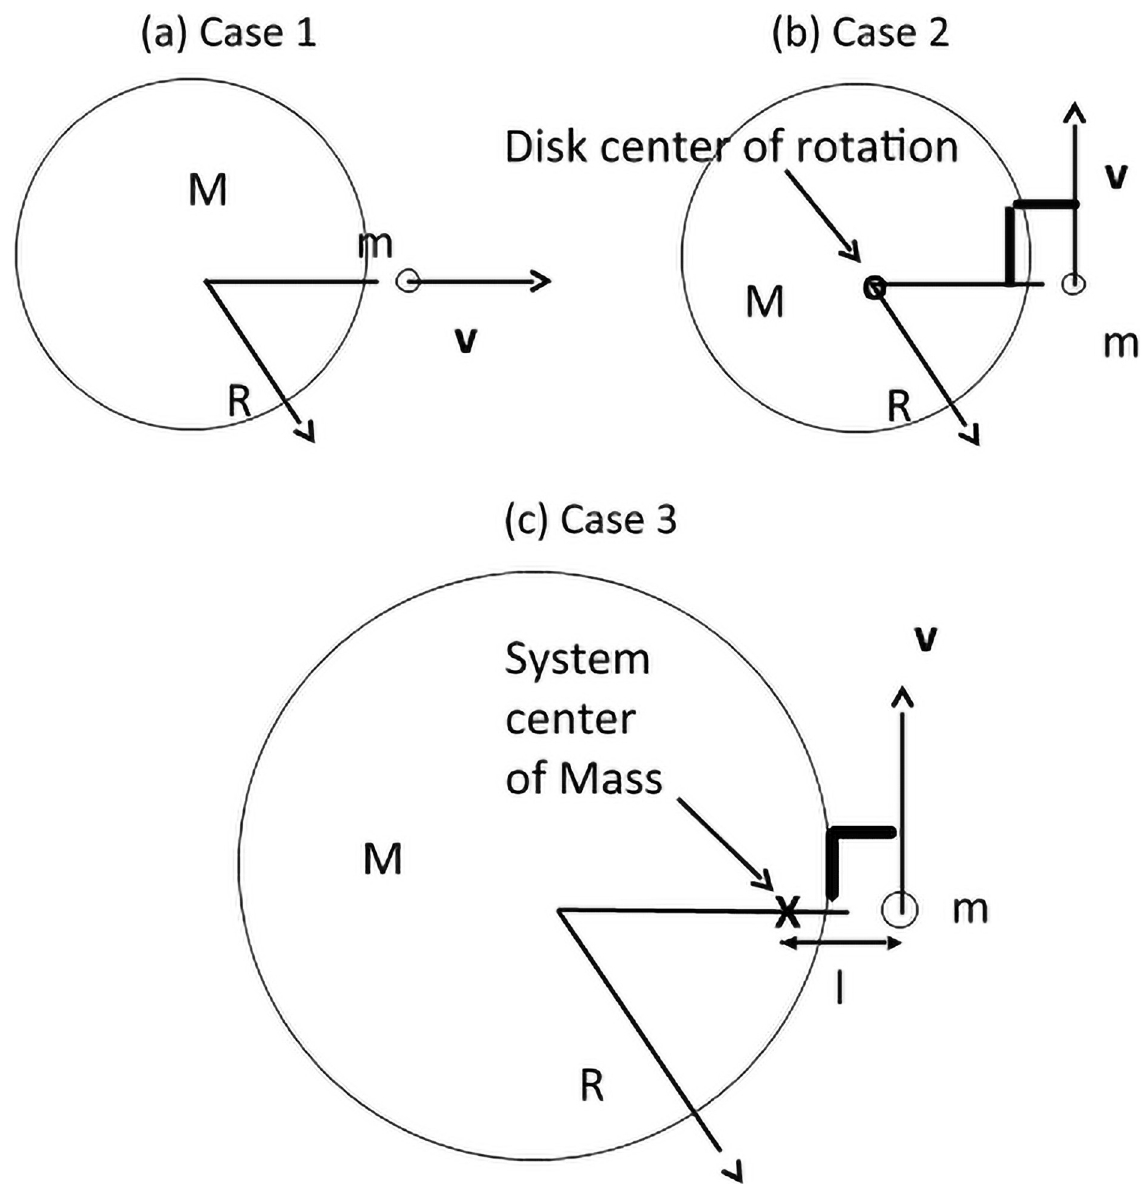
Fig 2. Three collision examples. As seen from above, schematic of a person (mass m) standing on the edge of a large platform (mass M). In (a), the person jumps radially from the disk edge at some velocity “v” and (b) jumps tangentially from a disk that is anchored to the ground by a frictionless pivot. In Case (c), the geometry is the same as (b) but the disk is not anchored to the ground by a pivot, the symbol “x” marks the center of mass of disk +